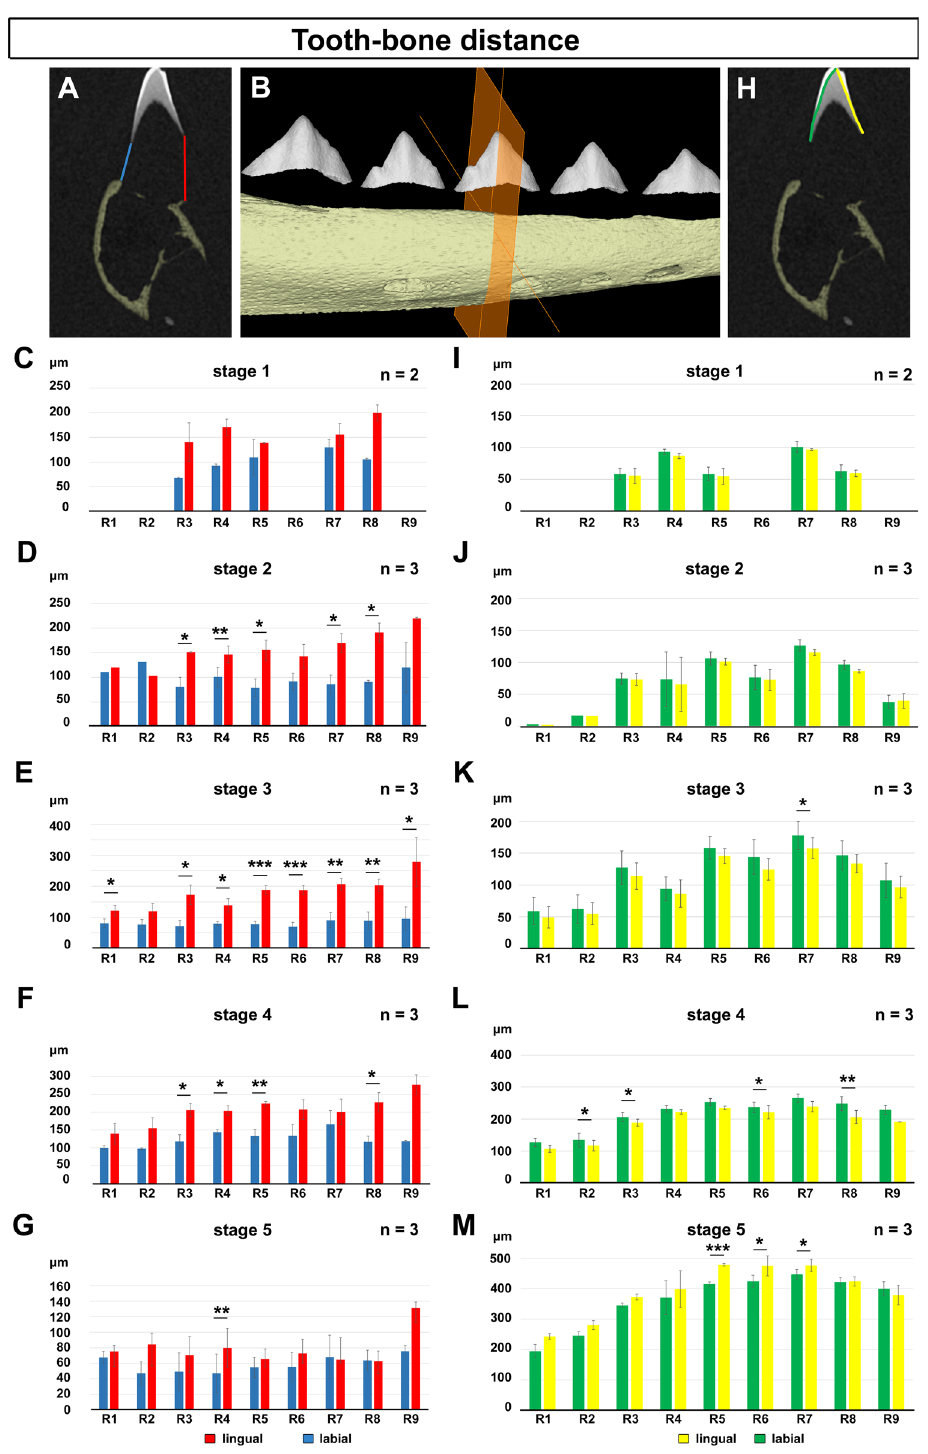
Figure 6. Tooth-bone distance and dentin deposition in chameleon. ( A – G ) Tooth to bone distance was measured on the transversal section through the central cusp ( B ). The distance was measured separately on the labial (blue) and lingual (red) side between the dentin and the nearest edge of the bony lamellae ( A ). Tooth-bone distance was found to be larger in the lingual side of the cervical loop at all analysed stages. ( H – M ) Analysis of dentin deposition on the labial (green) and lingual (yellow) side of the tooth germ. Analysis was performed at five different stages: stage1 ( C , I ), stage 2 ( D , J ), stage 3 ( E , K ), stage 4 ( F , L ) and stage 5 ( G , M ). n = number of analysed mandibles for each stage. Pair t-test was used to evaluate statistical significance of differences between labial and lingual part of the tooth. *p < 0.05, ** p < 0.01, *** p <